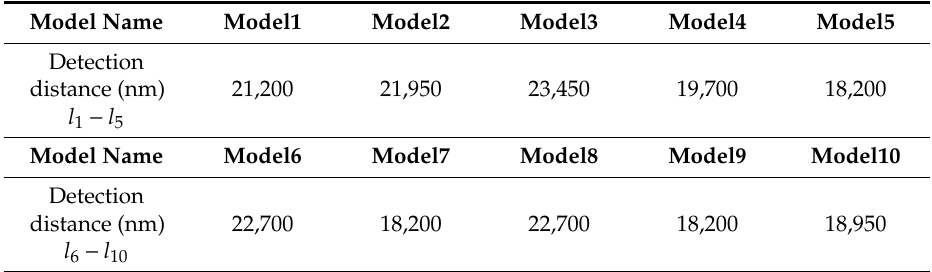
Table 5. Detection distances ( l i ( i = 1,2, ... ,10 ) ) obtained by calculation from model1 to